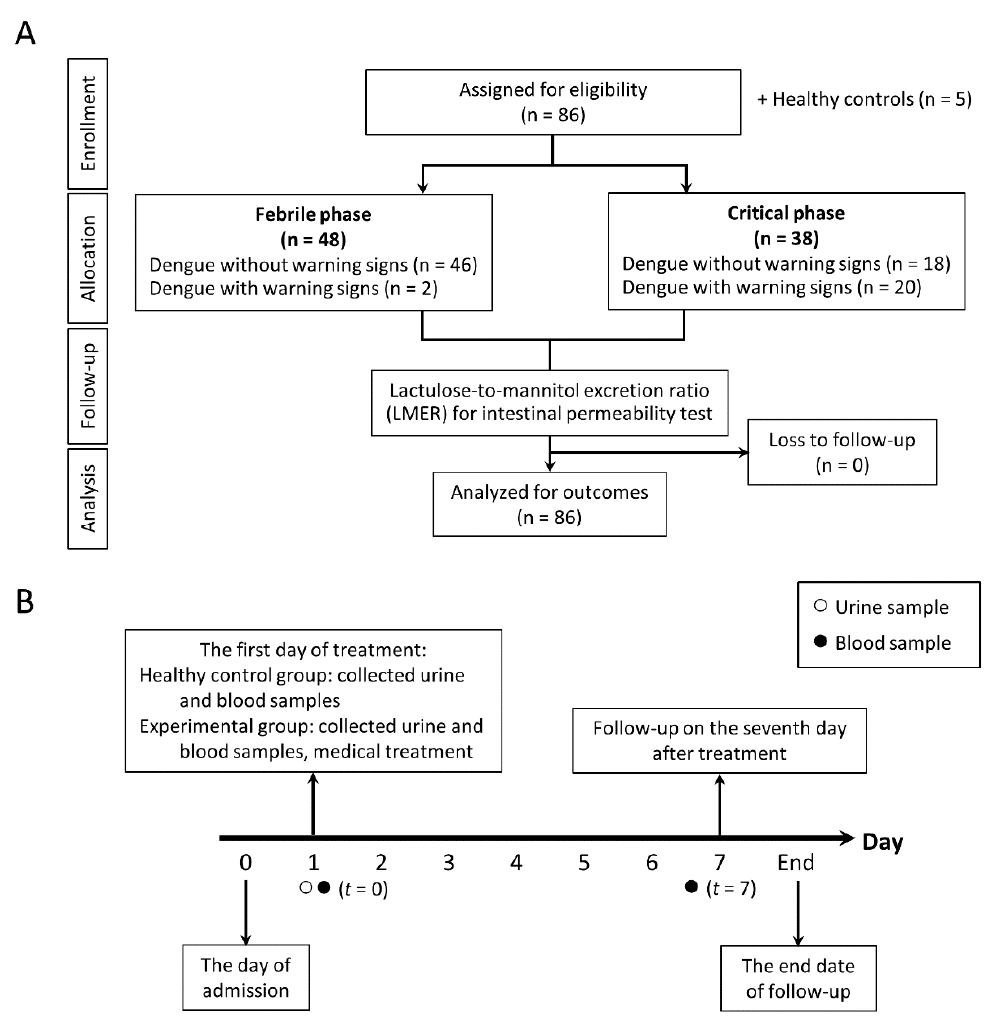
Figure 1. The schematic diagram represents ( A ) study flow diagram and ( B ) timeline of the study Figure 1. The study flow diagram and timeline of the study design. ( A ) The detailed procedure of the study design; ( B ) the timeline of the study.